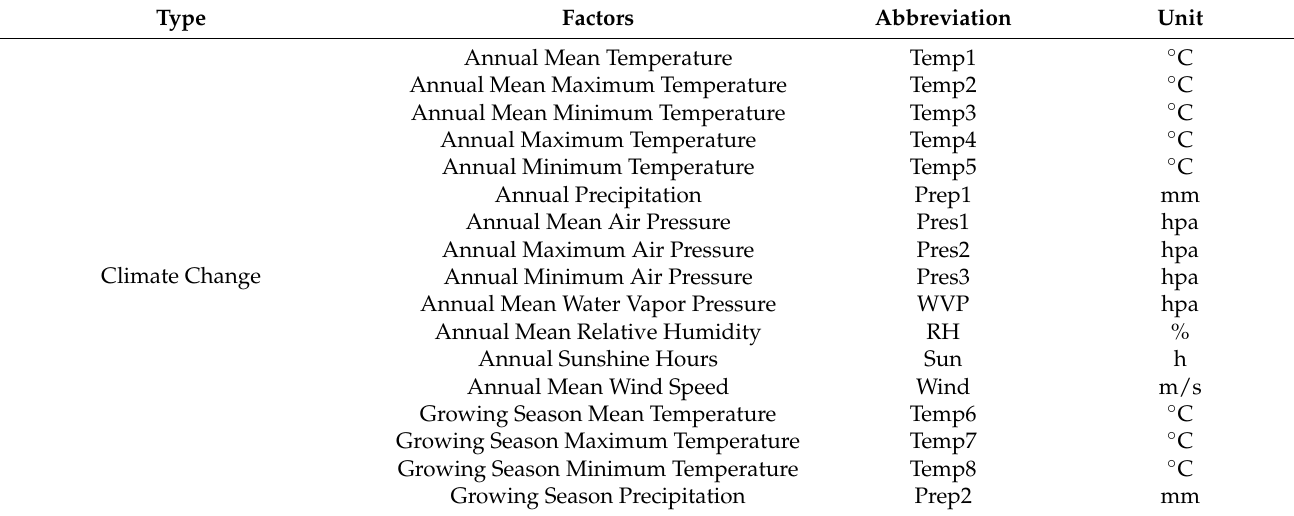
Table 2. Grassland change driving